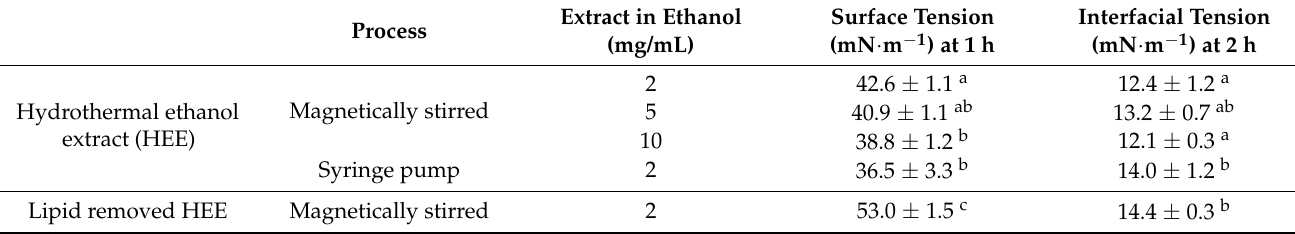
Table 2. Surface tension of colloidal particle dispersions from the hydrothermal ethanol extract (HEE) and lipids removed HEE (LR-HEE) from first peak, at various concentrations (2, 5, 10 mg/mL) and two production techniques (magnetic stirring and syringe pump). Different letters indicate statistically significantly different surface tensions with surface tension and interfacial tension assessed separately. p = 0.05, ANOVA.